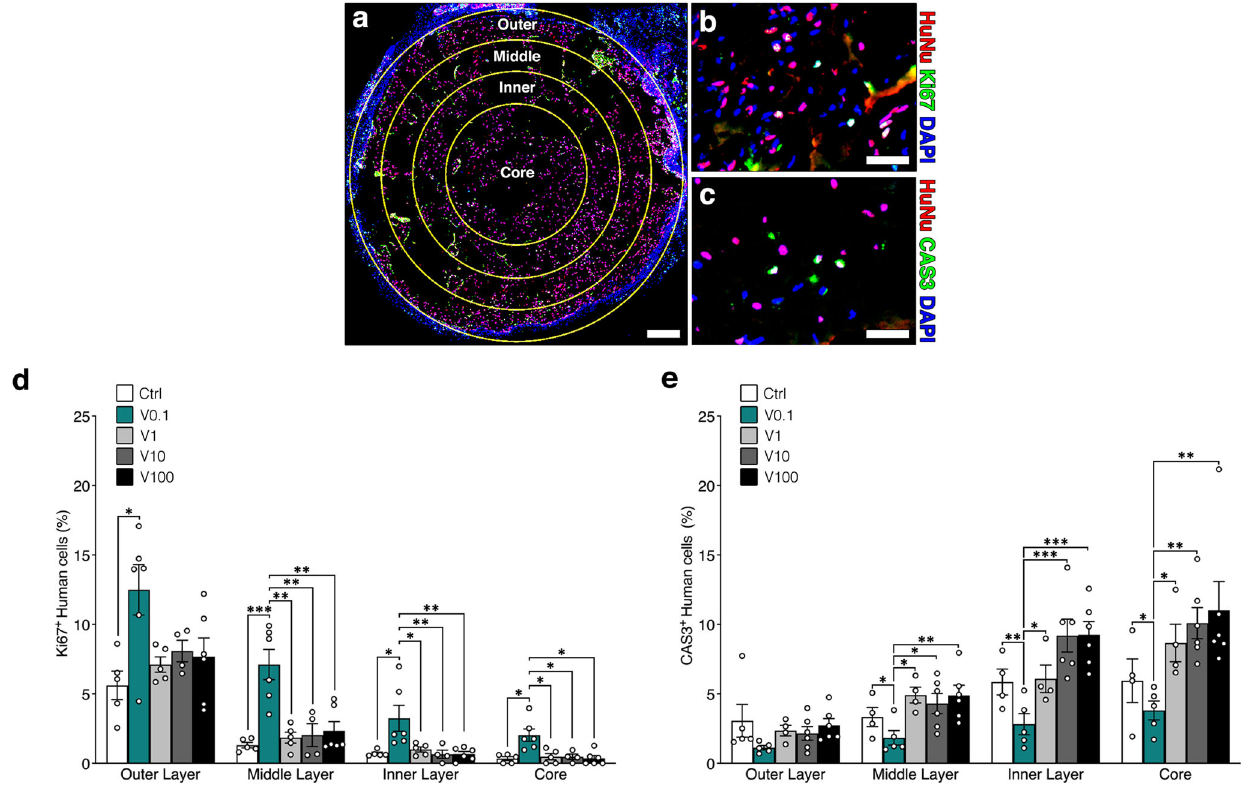
Fig. 3 Human BMSC survival and proliferation. a Reconstruction of graft sections under fl uorescence microscopy (layer subdivision in yellow); b Example of immunostaining of human nuclei (HuNu, in red), proliferating cells (Ki67, also in the nucleus, in green) and all nuclei (DAPI, in blue) of constructs (representative picture of the outer layer of TG-VEGF 0.1 μ g/ml condition) after 1 week of in vivo implantation; c Immunostaining of human nuclei (HuNu, in red), dying cells (CAS3, also in the nucleus, in green) and all nuclei (DAPI, in blue) of constructs (representative picture of the middle layer of TG-VEGF 10 μ g/ml condition) after 1 week of in vivo implantation d Quanti fi cation of proliferating human cells (%) in each layer. e Quanti fi cation of dying human cells (%) in each layer. Values are expressed as mean ± s.e.m.; * p < 0.05, ** p < 0.01, *** p < 0.001. N = 4 – 6. Scale bars ( a ) = 500 µm; ( b , c ) = 50